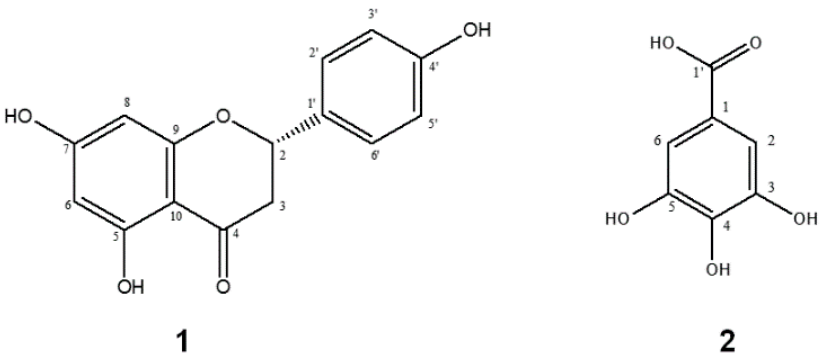
Figure 2. Chemical structures of compounds 1 and 2 .